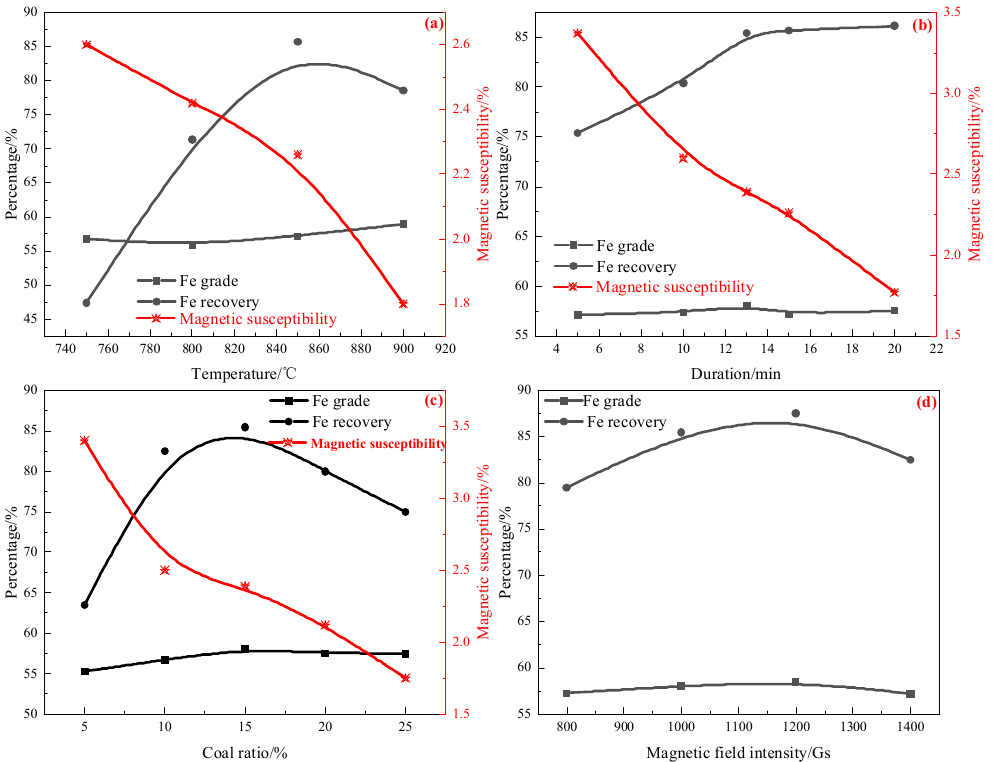
Figure 5. Effect of magnetization roasting parameters on iron grade, iron recovery, and specific susceptibility of roasted briquettes: ( a ) roasting duration of 15 min, magnetic field intensity of 1000 Gs; ( b ) roasting temperature of 850 °C, magnetic field intensity of 1000 Gs; ( c ) roasting temperature of 850 °C for 13 min, magnetic field intensity of 1000 Gs; ( d ) roasting at 850 °C for 13 min, grinding fineness of 80% less than 0.045 mm.